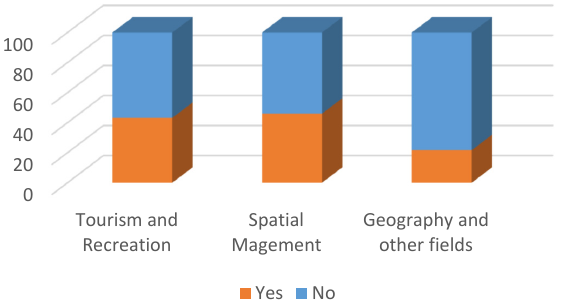
Figure 6. Survey question: Is the change in the perception of the landscape related to the “lockdown” resulting from the sanitary regime? (%).